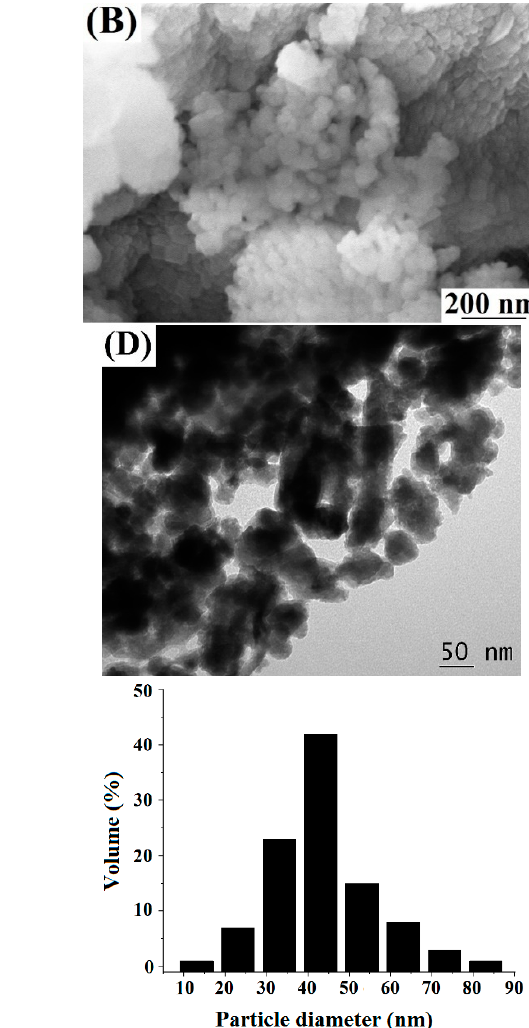
Figure 8. DTA and TG data for sample 5 .